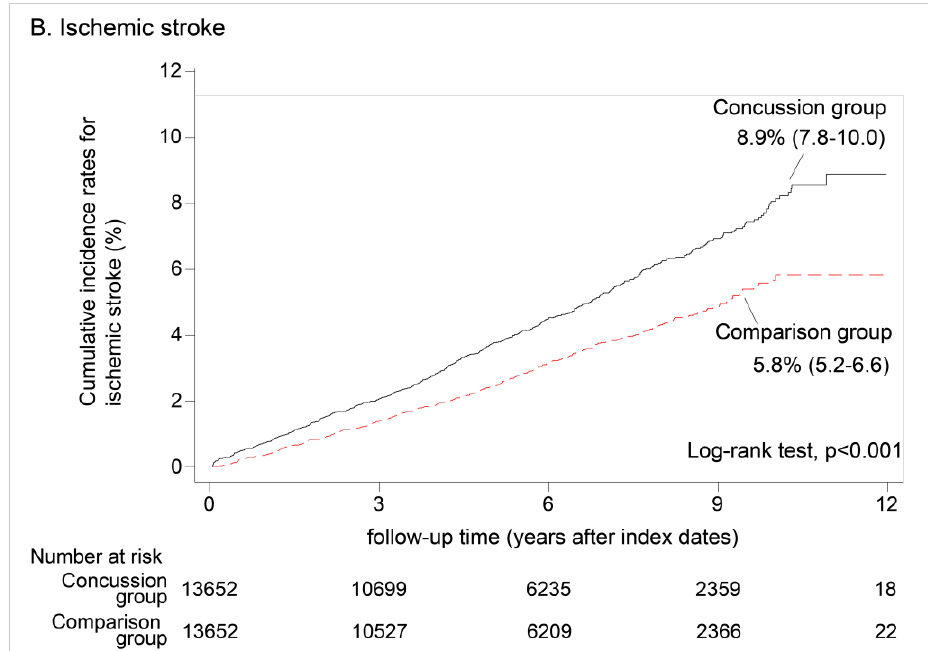
Figure 3. Cumulative incidence rates of ( A ) hemorrhagic and ( B ) ischemic strokes of the concussion group and the comparison group ( n = 27,304, 1998–2005).